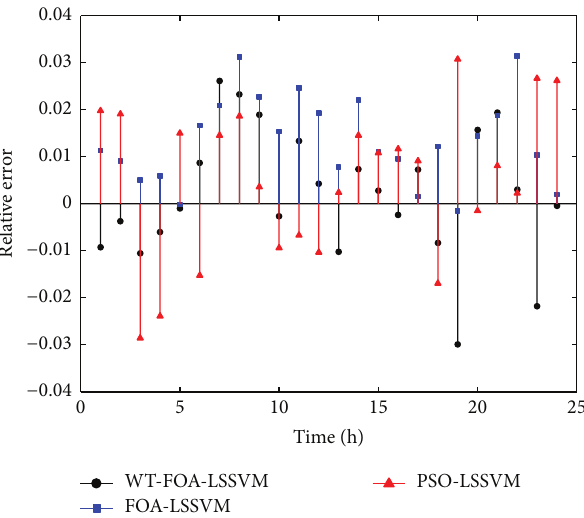
Figure 8: Actual load and forecasting results of WT-FOA-LSSVM, LSSVM, and BPNN.